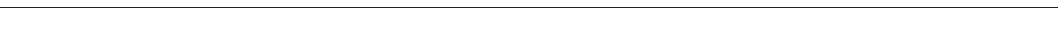
Fig. 8 IFN gene therapy boosts activation of adoptively transferred CAR19-transduced T cells and enhances survival. a , b Experimental design ( a ) and ALL growth over time ( b , absolute numbers in PB; mean ± SEM) in CTRL + CTRLT ( n = 5), IFN + CTRLT ( n = 5), CTRL + CART19 ( n = 7), IFN + CART19 ( n = 7). **** p < 0.0001, nonparametric rank-based method for longitudinal data in factorial experiments. c Percentage (mean ± SEM) of Lag3 expression